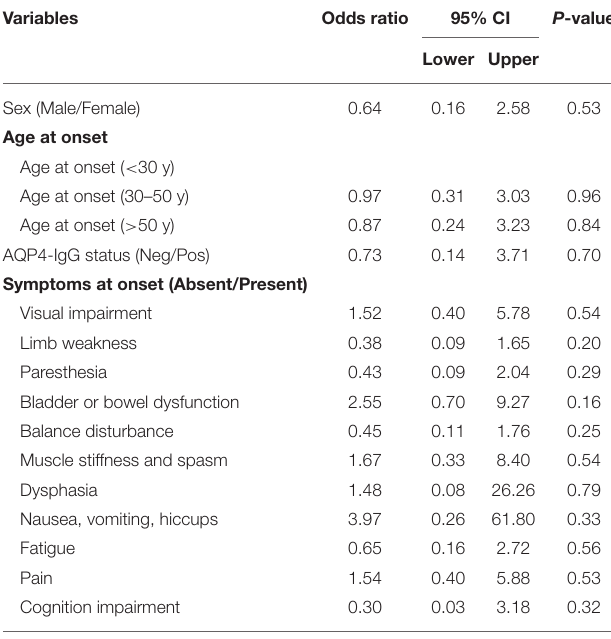
TABLE 1 | Summary of the demographic and clinical data of patients with NMOSD.